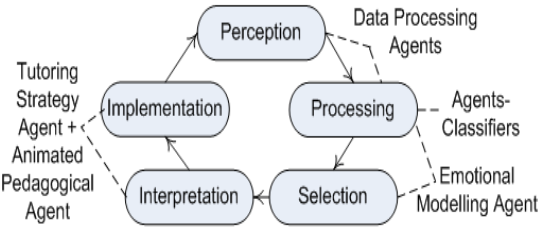
Fig.4. Involvement of the agents into the affective